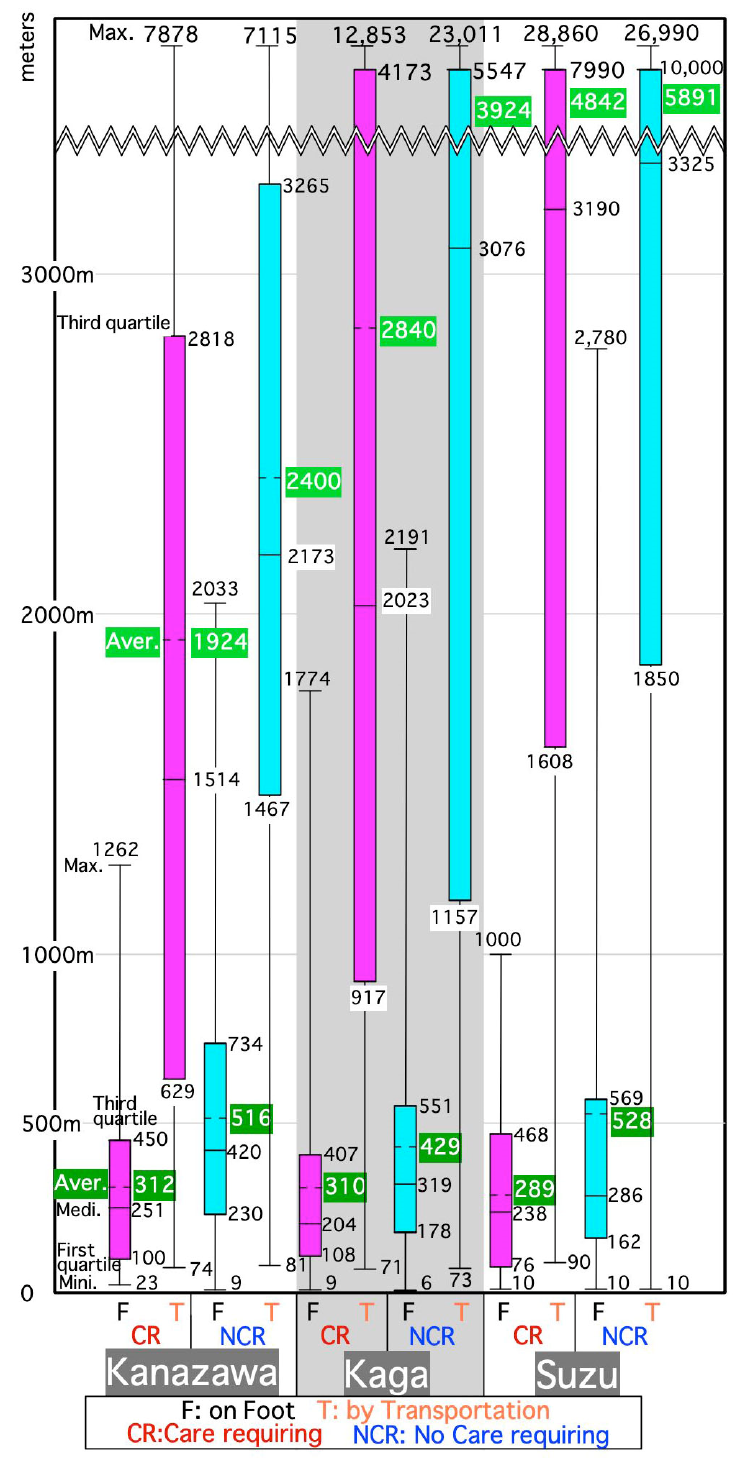
Figure 6. Distribution of all single outing straight-line distances of participants in three target cities (unit: meters).